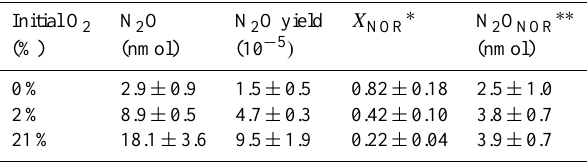
Table 4. Estimated contribution of NO − NOR to N 2 O production by N. oceani under different initial O 2 concentrations.